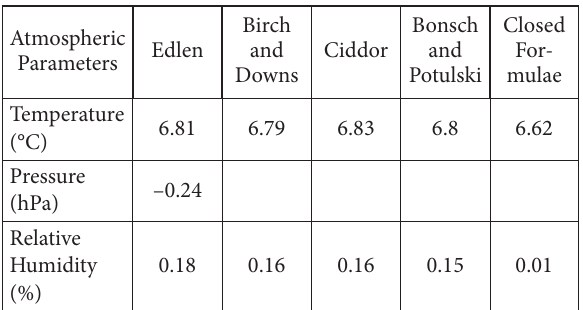
Table 4. EDM corrections w.r.t atmospheric changes calculated in each model